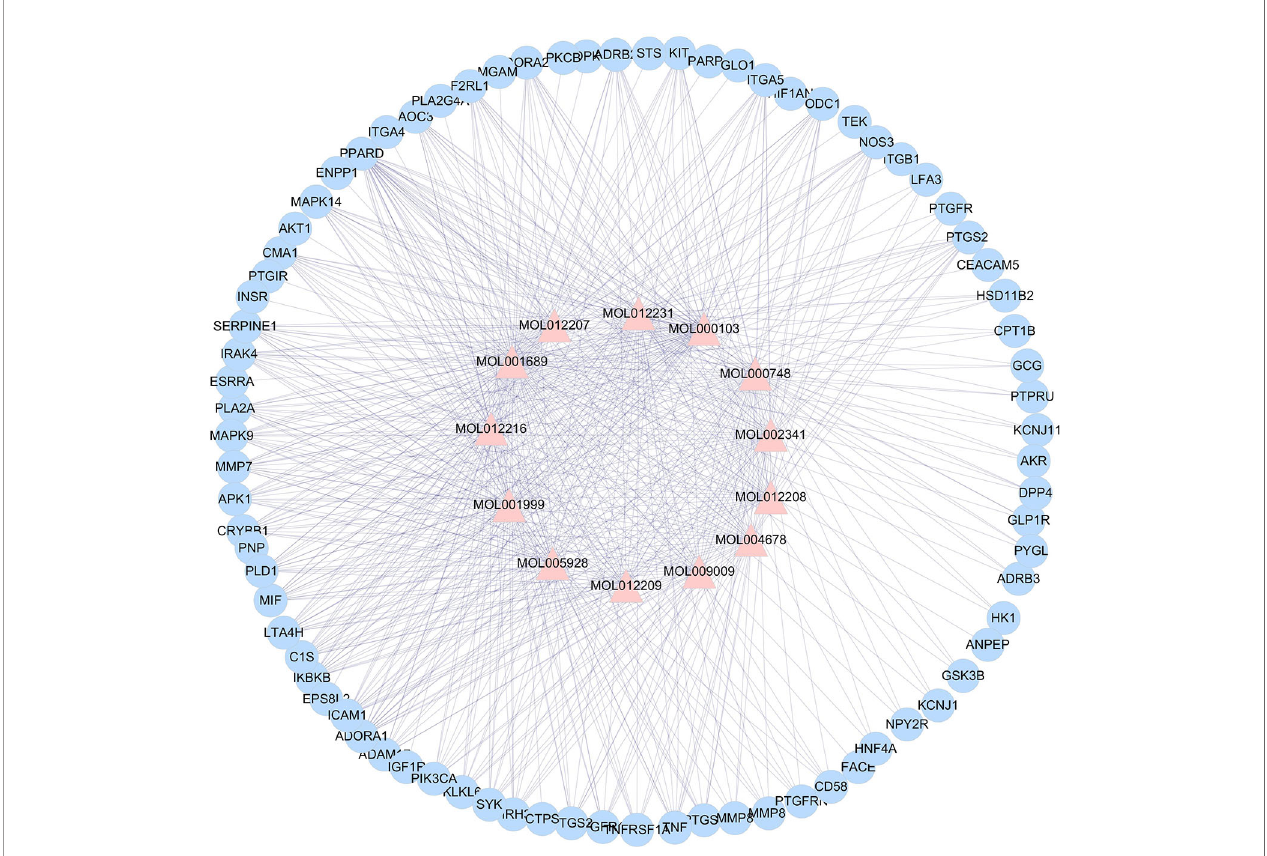
FIGURE 2 | Lobelia chinensis ingredients – target interaction network. The pink triangle represent the 13 bioactive ingredients, and the blue circle represent the 80 target